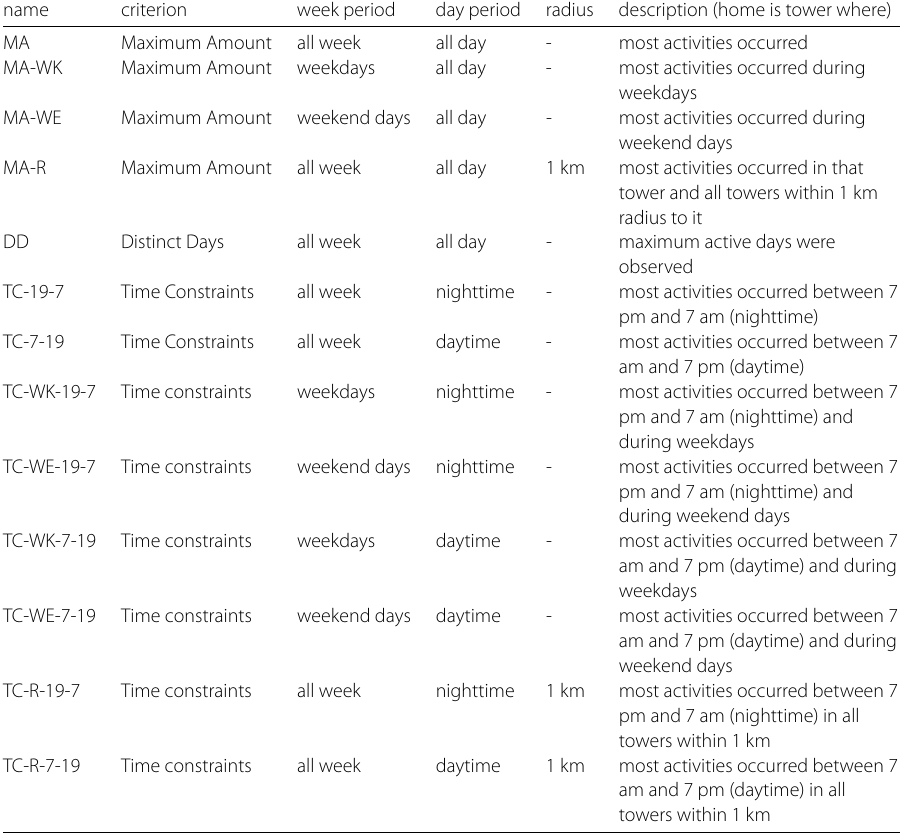
Table 3 Characterization of the considered HDAs according to their criterion, week period, day period, and space